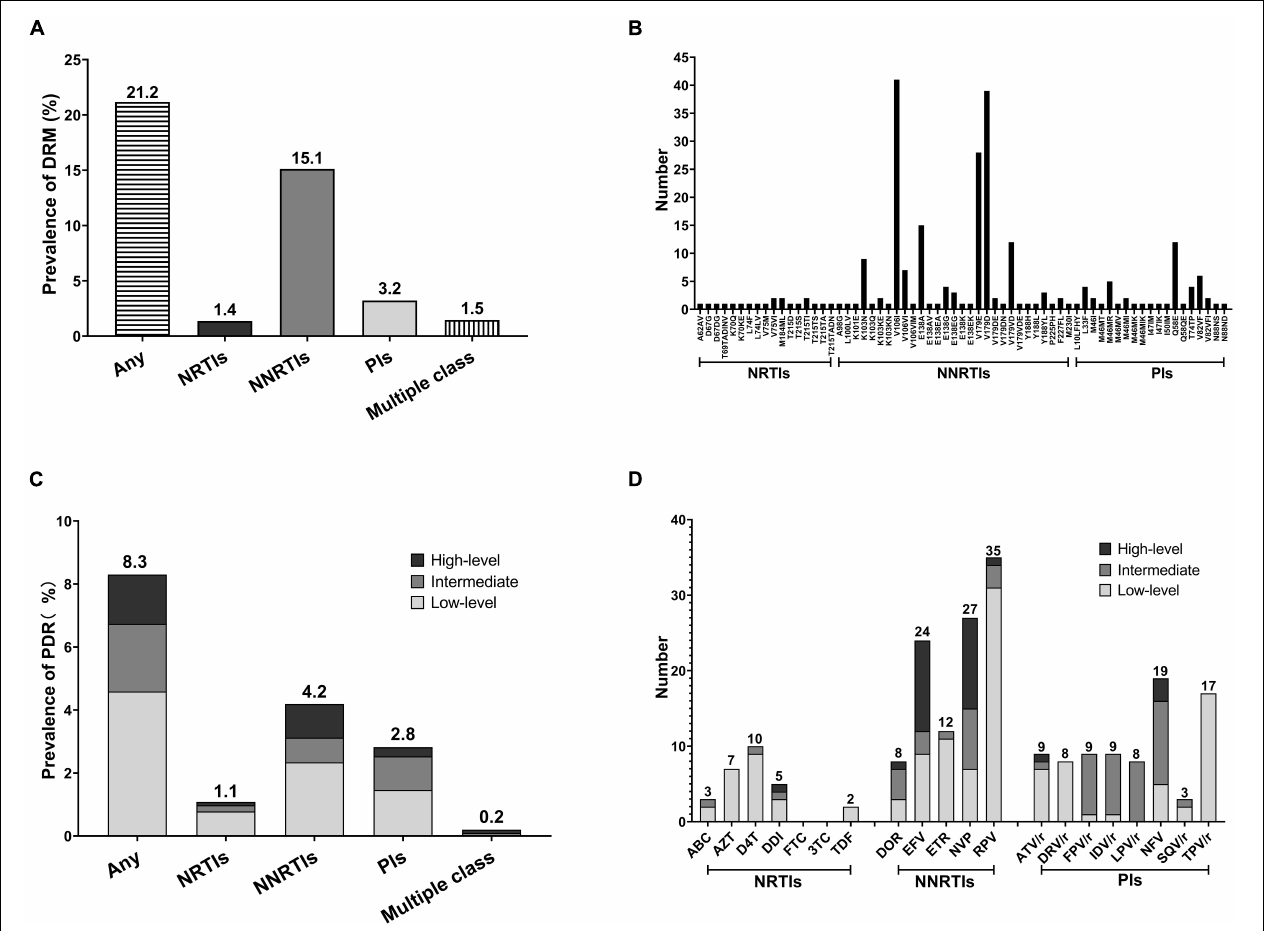
FIGURE 1 | Prevalence and frequency of HIV-1 drug resistance mutation (DRM) and pretreatment drug resistance (PDR) in two severe drug abuse regions in Guangxi, 2015–2019. (A) HIV-1 DRM prevalence by drug class. (B) Frequency of NRTIs, NNRTIs, and PIs DRMs. (C) HIV-1 PDR prevalence by drug class and drug resistance (DR) level. (D) Frequency of HIV-1 PDR to 20 antiretroviral (ARV)